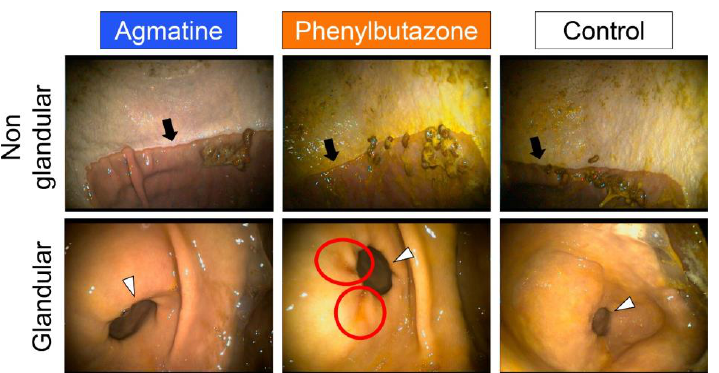
Figure 6. Representative gastroscopic images of equine non-glandular and glandular gastric mucosa after 30 days of oral agmatine ( left ), phenylbutazone ( middle ) or control ( right ) administration. Ulcers in the glandular region are indicated with red circles. The margo plicatus (black arrows) and pylorus (white arrowheads) are also visible.